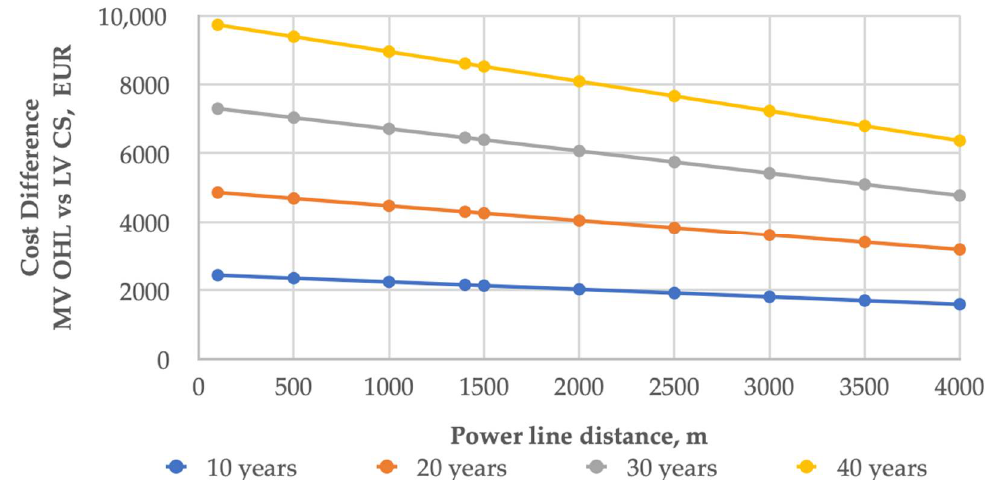
Figure 2. Difference between the total costs of the MV OHL and the LV CS (positive cost if LV CS is more feasible, negative cost if MV OHL is more feasible).